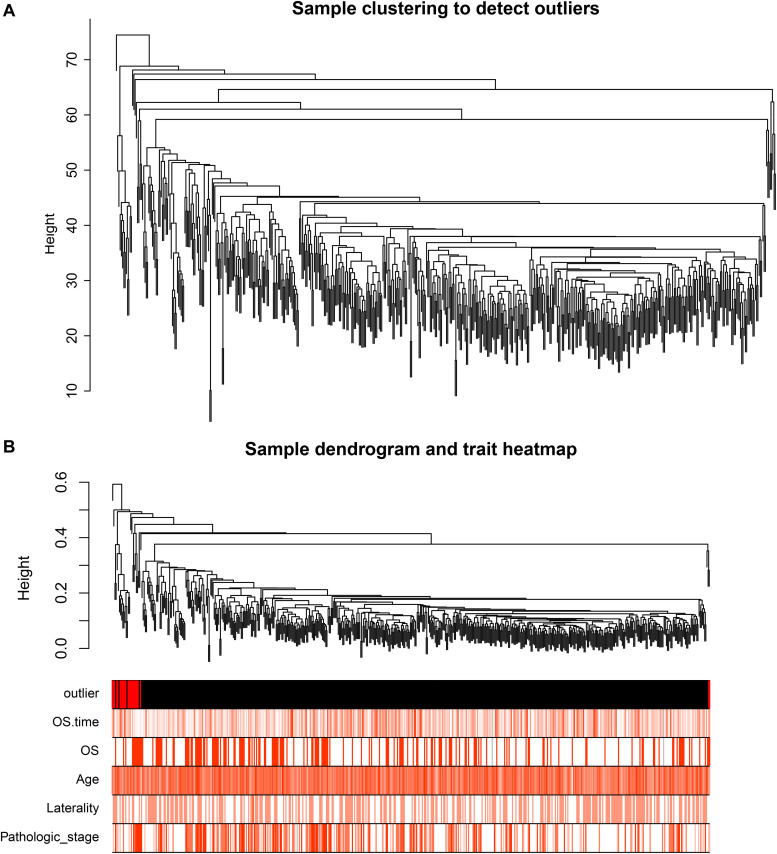
(A) Sample clustering to detect outliers. (B) Sample dendrogram and trait heat map. The color intensity was proportional to older age, OS (overall survival) time, OS, gender, laterality, and pathologic stage.